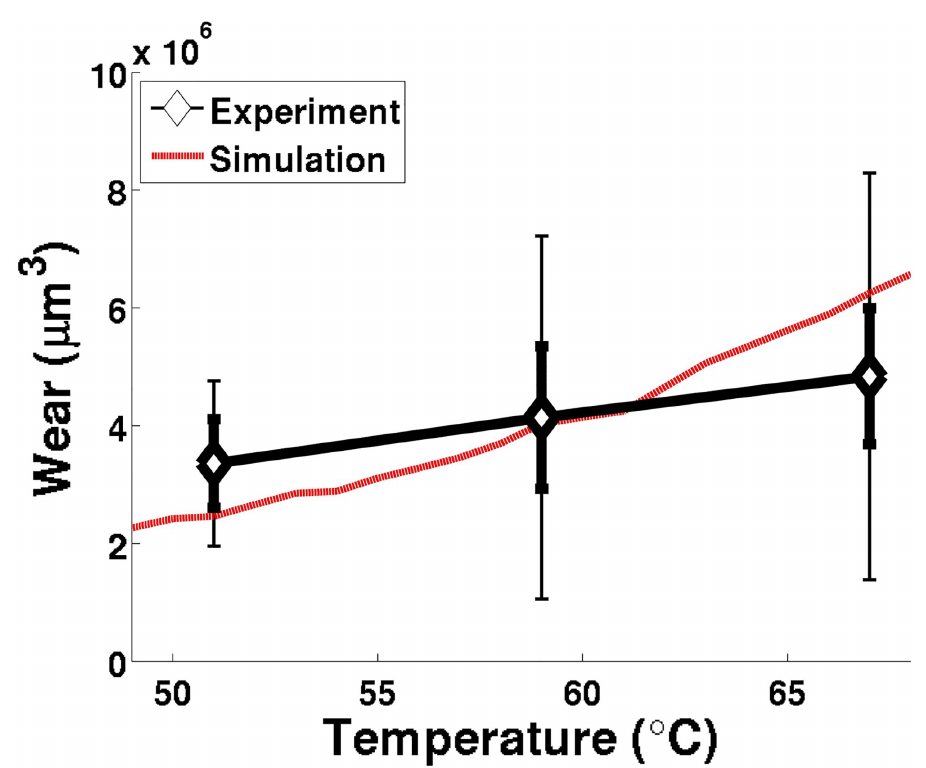
Fig 12. Wear ( μ m 3 ) experimental data and matching simulation results as a function of bulk lubricant oil temperature (˚C). Diamondsrepresent the experimental averagewear, whileerror bars represent the average(thick error bars) and maximum (thin error bars) experimental variationof the wear observed betweenall six samples (two repeating tests with three ball bearingseach).